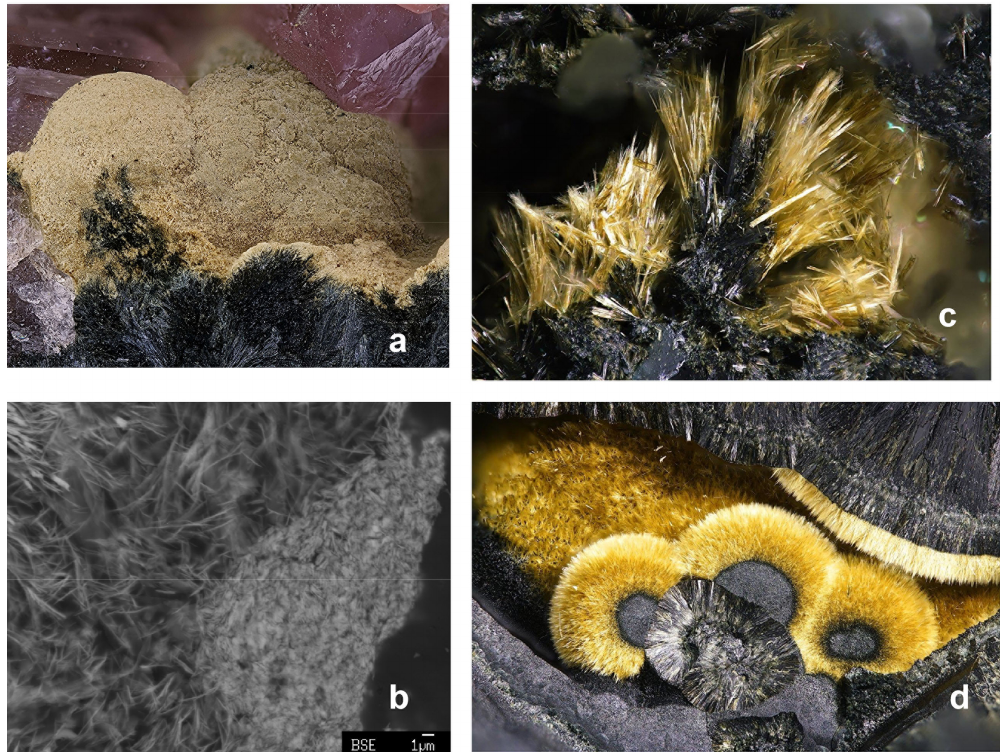
Figure 1. (a) Earthy yellow kenngottite crust on rockbridgeite, associated with pink hureaulite in specimen IGC135 (FOV = 4.4mm; field of view). (b) SEM BSE image showing microtexture of earthy kenngottite. (c) Yellow kenngottite fibres on rockbridgeite in specimen Hag510 (FOV = 1mm). (d) Radial growth of kenngottite on rockbridgeite (FOV = 3.9mm). Photo credit: (a) Volker Betz; (c, d) Christian